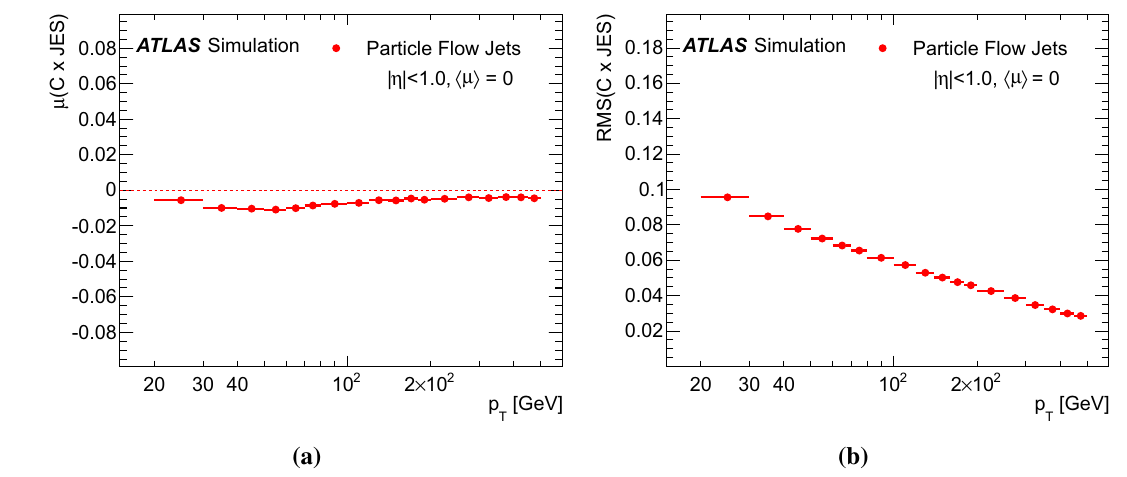
error bars denote the statistical uncertainty. The MC samples used do not include